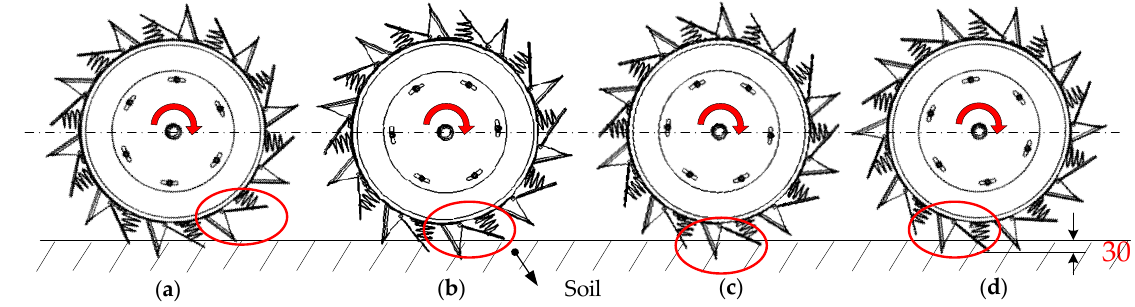
Figure 3. ( a – d ) Four places where the duckbill touches the soil.